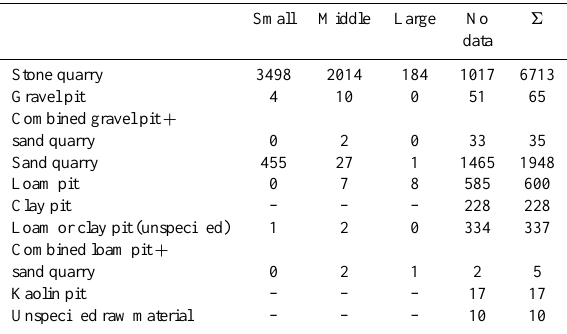
Table 1. Size characteristics of the mining sites. Small: up